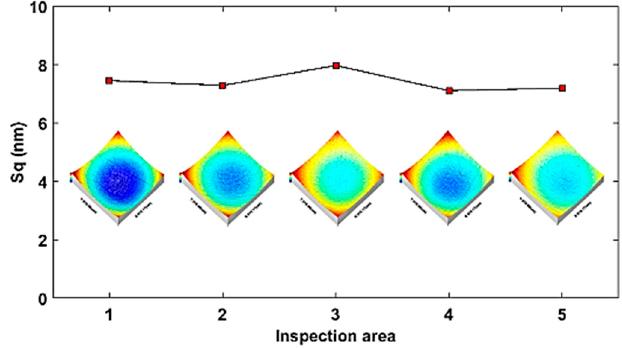
Figure 22. Design ( a ) and STS tool path ( b ) of MLA surface.